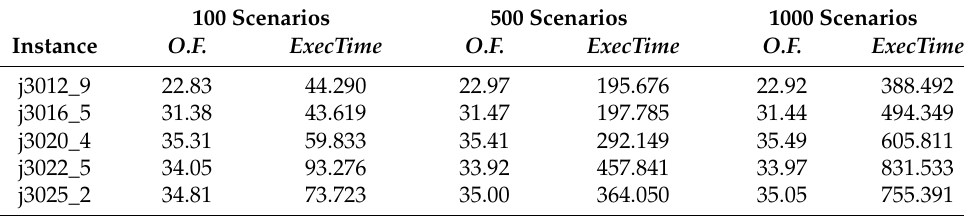
Table 13. Experiment 4 results. Different number of scenarios. Instances with 30 activities.